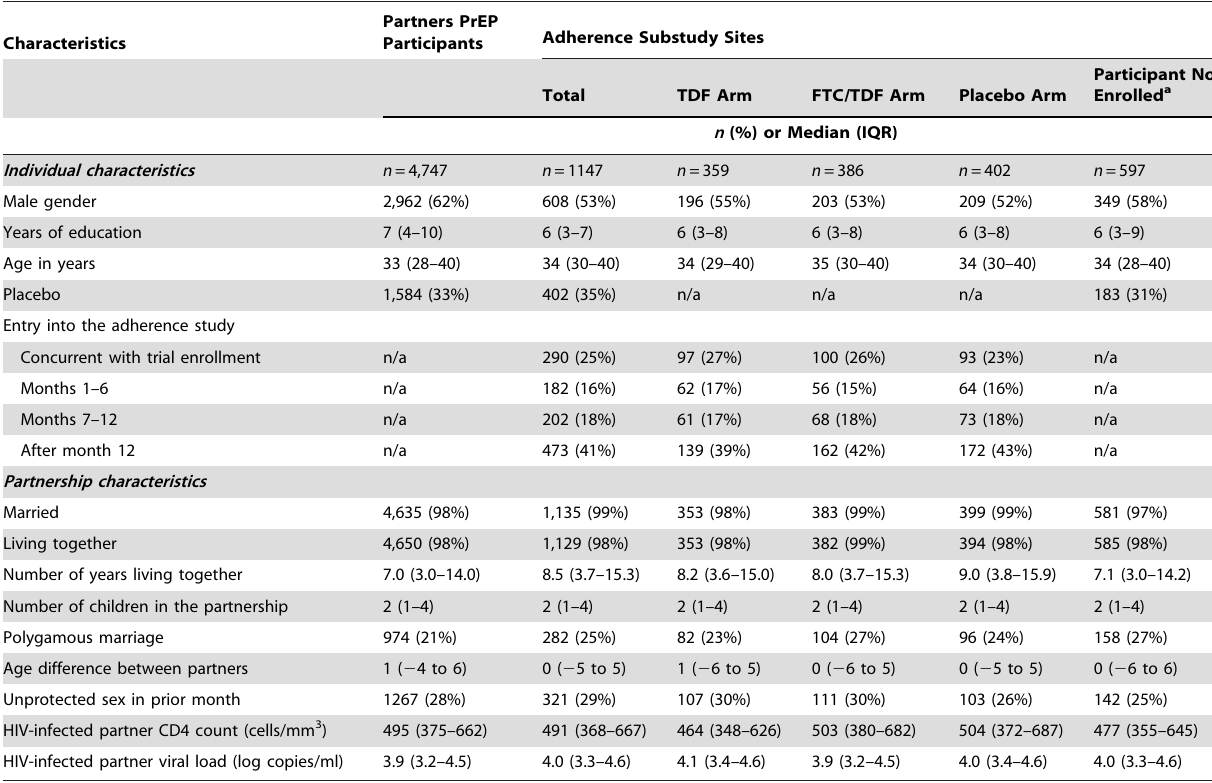
Table 1. Enrollment characteristics of study